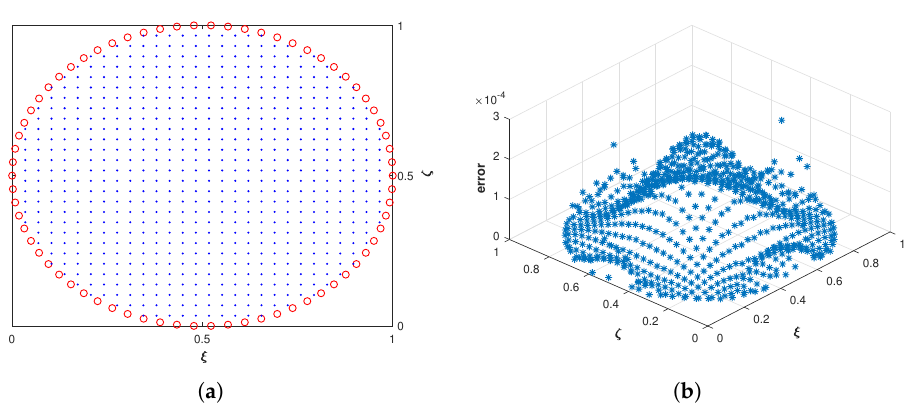
Figure 10. ( a ) Circular domain N = 718. ( b ) Absolute error corresponding to Problem 3 with α = 0.25, N = 718, n = 25, and M = 26. It is observed that the proposed scheme has acceptable accuracy.